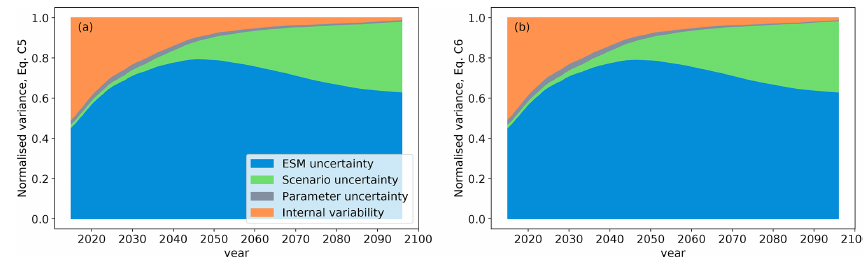
Figure C2. Variance components normalized with the total variance of the fit. (a) Calculated with Eq. (C5). (b) Calculated with Eq.